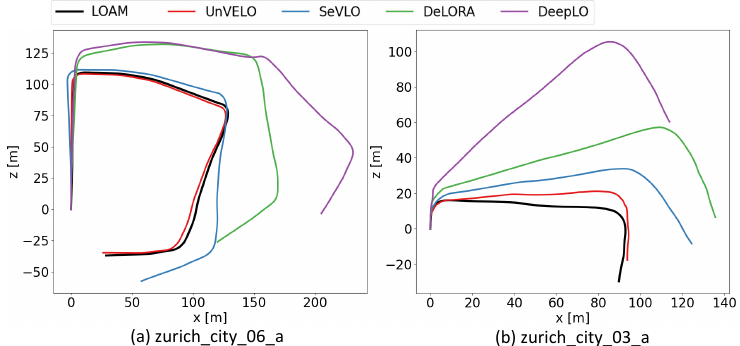
Figure 8. Trajectories of sequence “zurich_city_06_a” (day scenario) and “zurich_city_03_a” (night scenario) on